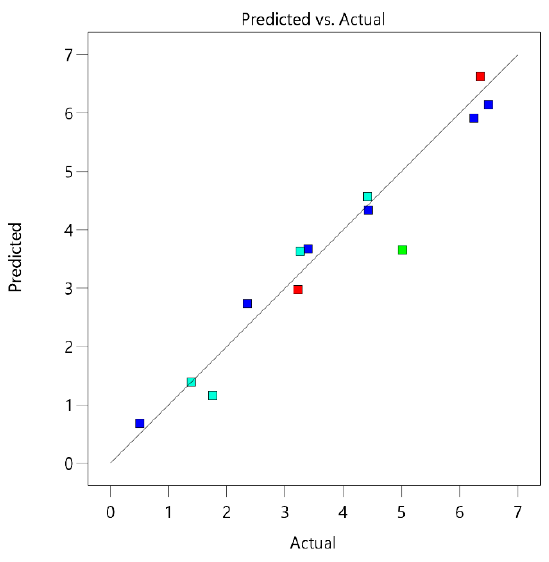
Figure 8. Parity plot of acetic acid yield. The obtained LC fraction yields (Figure 9) were in a range from 69% to 97%